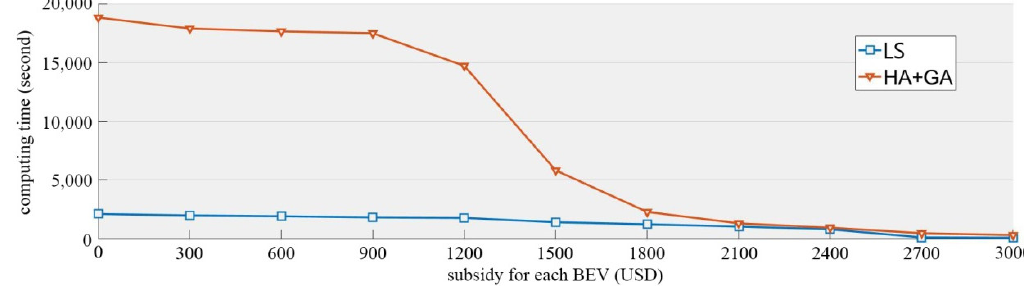
Table 4. Computational results of the three algorithms for the artificial networks with different scales.